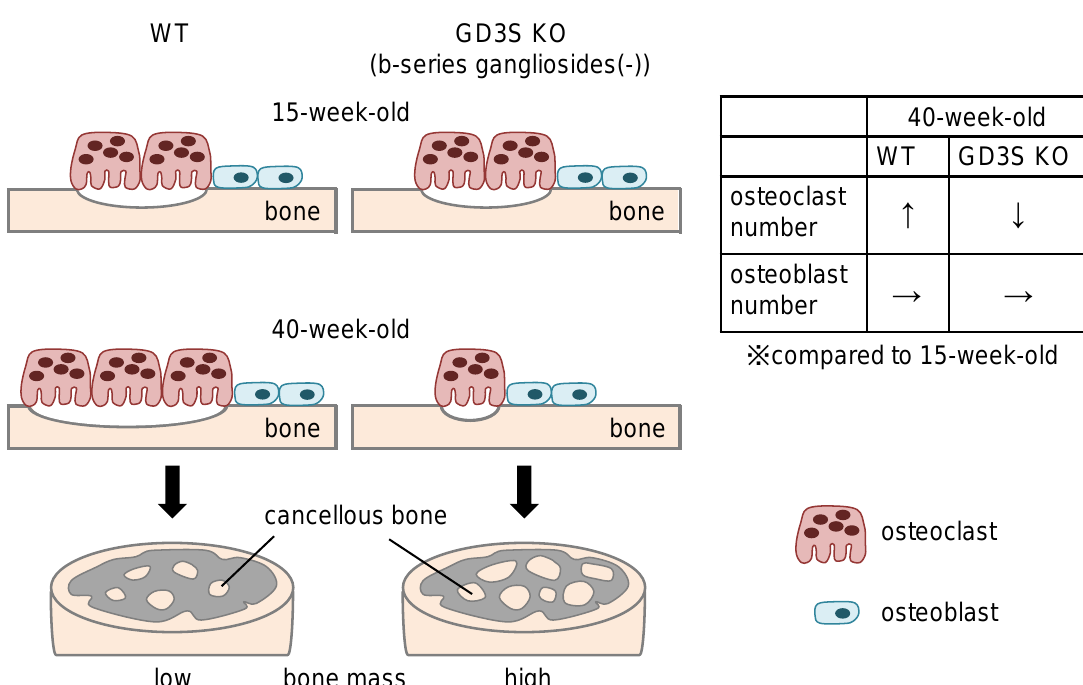
Figure 7. Schematic illustration of the proposed regulation of bone metabolism by b-series